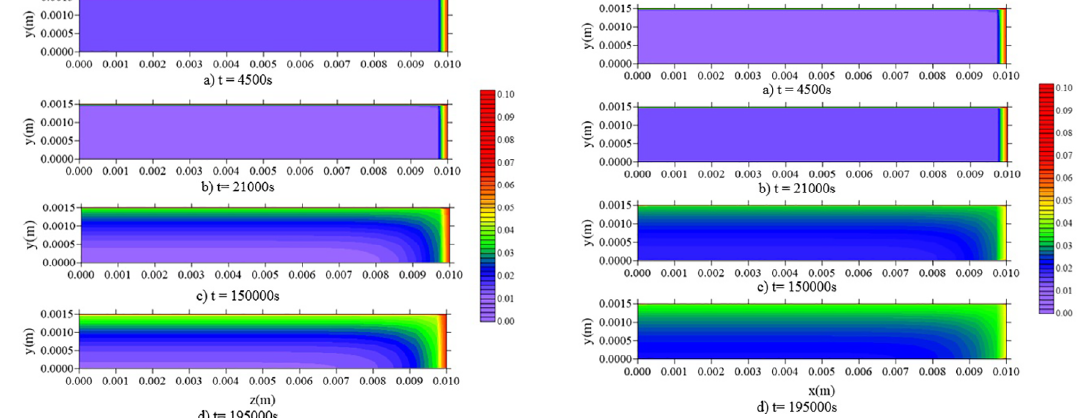
Figure 12. Distribution of the entrapped solute concentration (S) in y = R